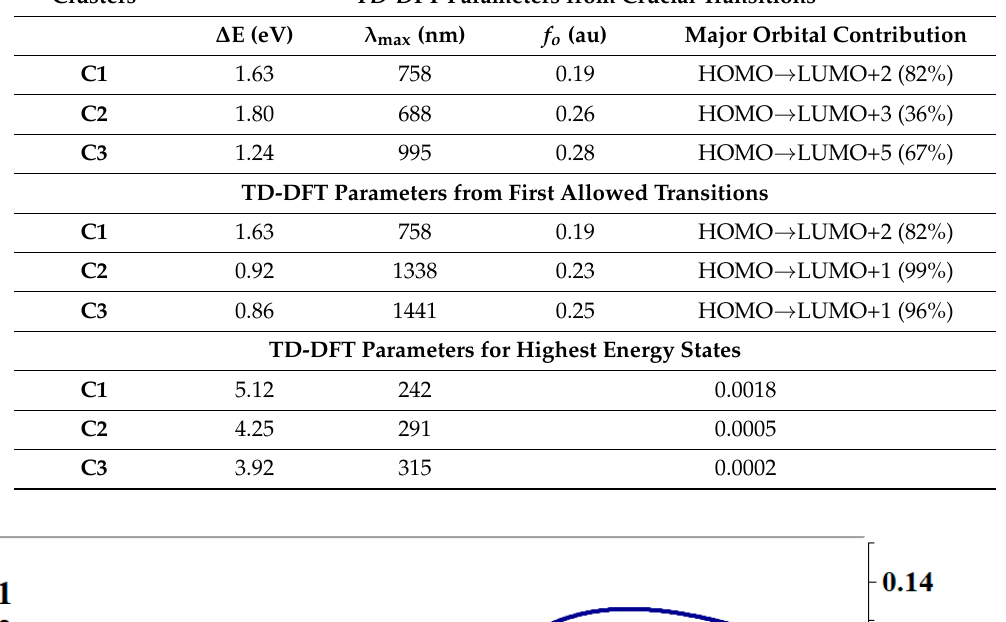
Table 3. TD-DFT parameters of crucial excited sates, first allowed transitions, and highest state for C1 to C3 clusters.